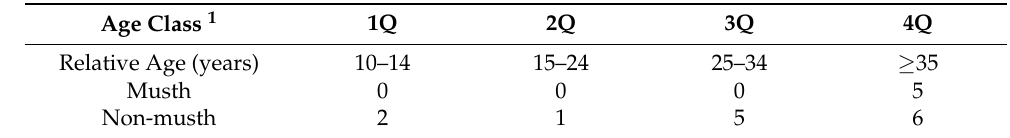
Table 1. Age class and musth status of male African elephants ( n = 19) subjected to estrous playback experiments at the Mushara waterhole in 2008. Individuals in the 1Q–3Q age range were grouped together for statistical analyses, whereas all males in the 4Q class were considered fully mature adults and further differentiated by reproductive state (musth or